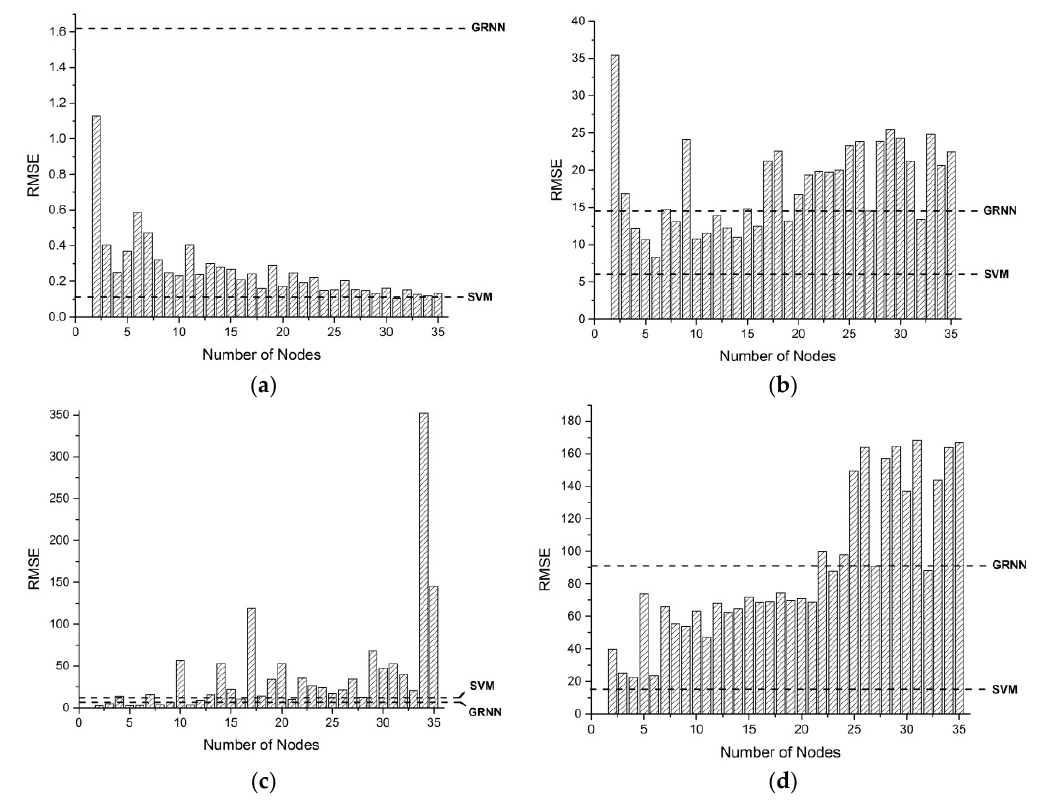
Figure 4. Root mean square error (RMSE) versus number of nodes of multilayer feed-forward neural networks (MLFNs). Bars represent the RMSEs; black dashed lines represent the RMSEs of general regression neural network (GRNN) and support vector machine (SVM). ( a ) Machine learning models for data provided by Fedele et al. [1]; ( b ) machine learning models for data provided by Ihmels et al. [24]; ( c ) machine learning models for data provided by Klomfar et al. [25]; and ( d ) machine learning models for data provided by all the three experimental reports [1,24,25]. Table 1. Prediction models using experimental data by Fedele et al. [1].